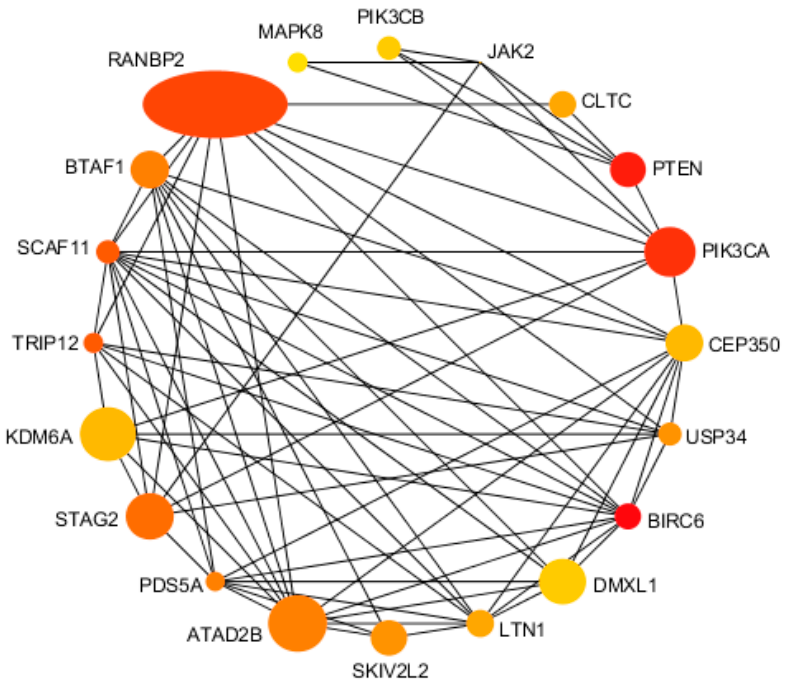
Figure 10. Top 20 proteins. The size of the dot represents the difference multiple, and the larger the difference multiple, the larger the dot, the smaller the difference multiple and the smaller the dot. The dot color represents the score of Degree algorithm. The redder the color, the higher the score, and the yellower the score. The connection between dots indicates the interaction between proteins.